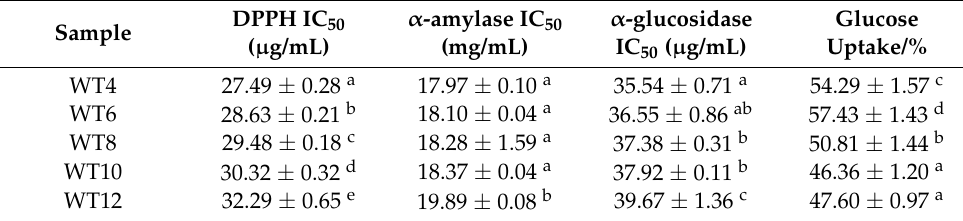
DPPH, 2,2-diphenyl-1-picrylhydrazyl; IC 50 indicates the scavenging or inhibitory concentration required